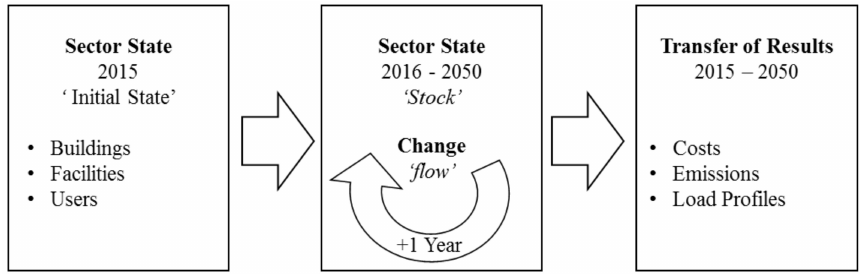
Figure 2. Schematic overview of the stock-and-flow model of domestic